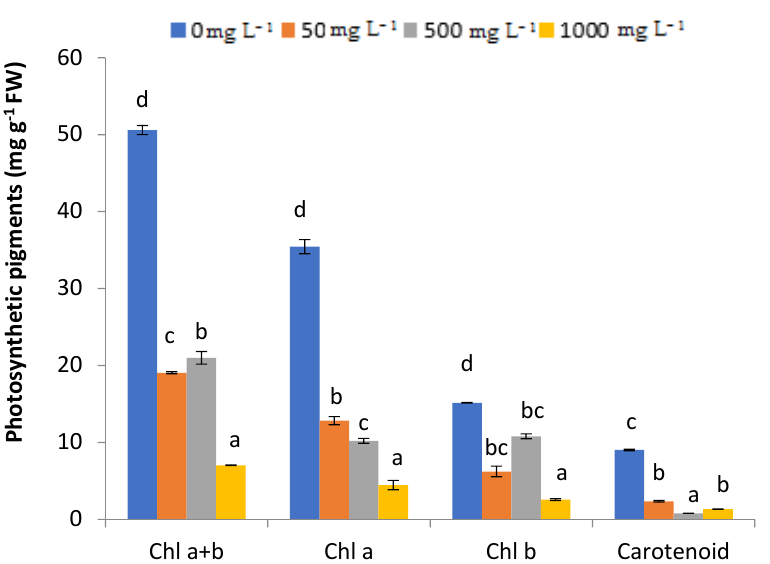
Figure 3. Effects of PbCl 2 concentrations (0. 50, 500, 1000 mg L − 1 ) on chlorophyll content and carotenoid of treated fenugreek after three months of exposure. All the values are mean of triplicates ± SD. ANOVA significant at p < 0.05. Different letters indicate significantly different values at a particular chlorophyll pigments and carotenoid (DMRT, p < 0.05).